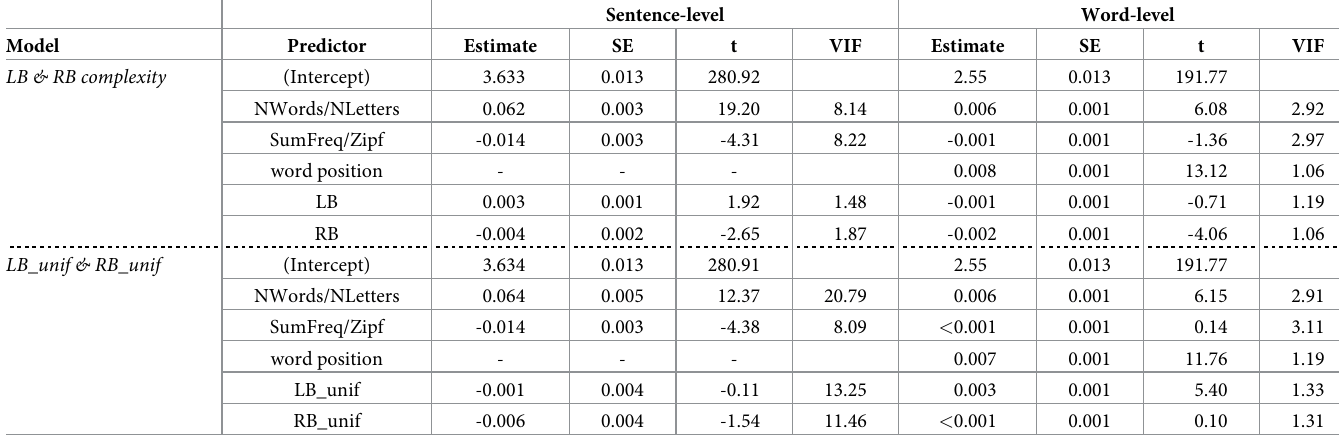
Table 4. Results of the mixed-effects models concerning syntactic complexity (SC). Model